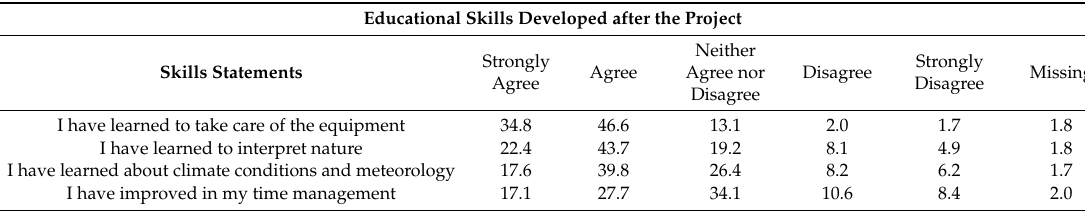
Table 6. Education and learning after the